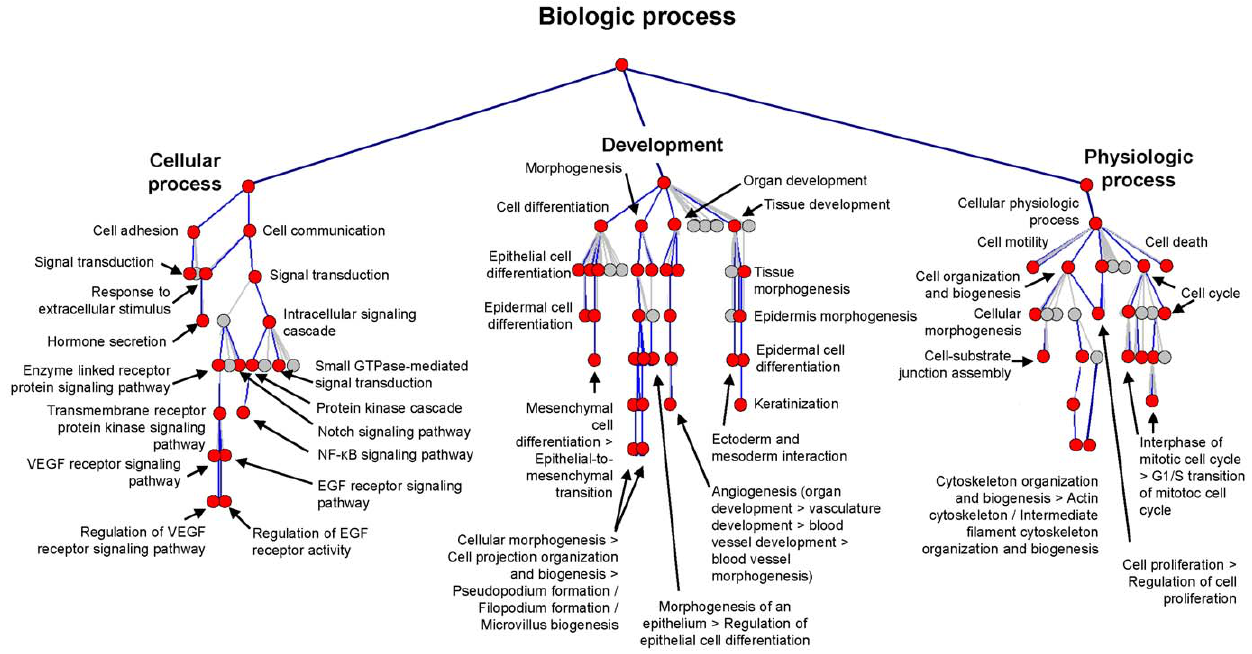
Figure 4. Hierarchical mapping of Gene Ontology (GO) categories enriched in the human basal cell transcriptome. Basal cell-enriched gene probe sets (n=1,828) were used to generate a GO tree using GoSurfer software to display ‘‘biologic process’’ categories related to ‘‘cellular process’’ (left branch), ‘‘development’’ (middle branch) and ‘‘physiologic process’’ (right branch). Significantly enriched categories (p , 10 2 10 ) are represented as red nodes; grey nodes represent mostly closely mapped nonsignificant categories; edges represent ‘‘parent-child’’ relationships of GO terms.